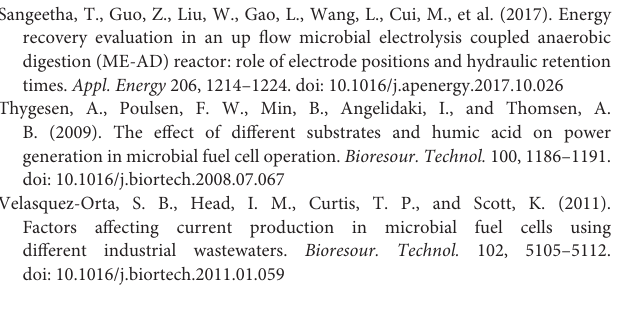
Table S1 | Experimental and calculated